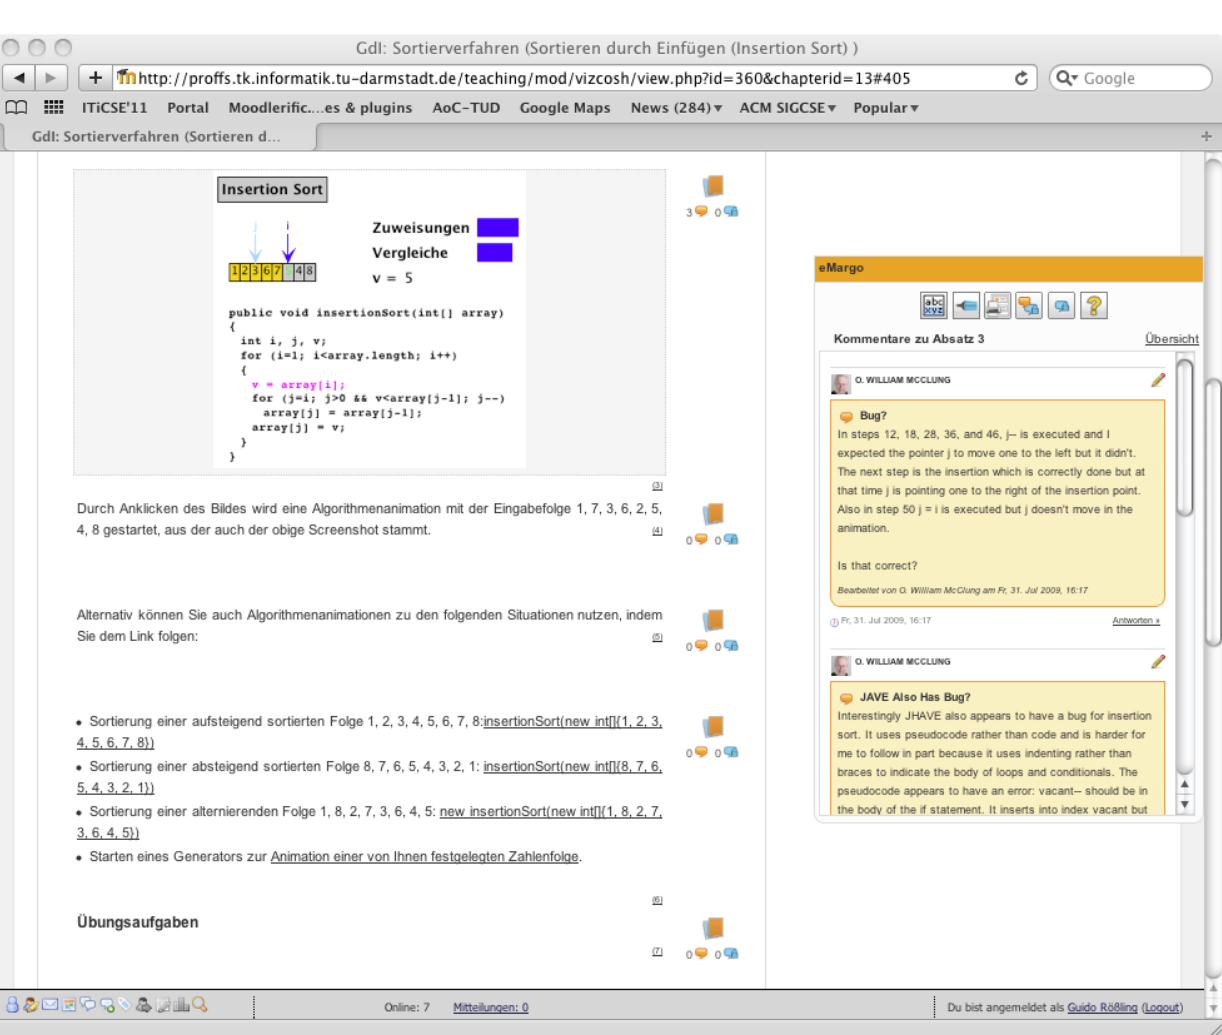
Figure 6. Example screenshot of a hypertextbook with an included A NIMAL